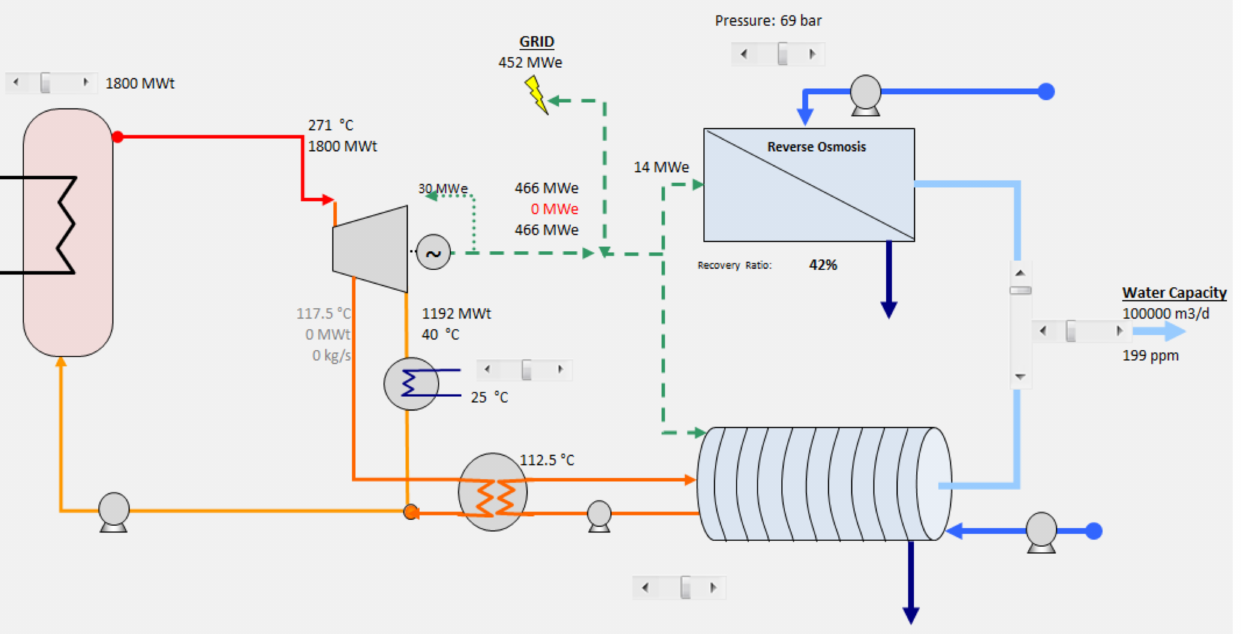
Figure 7. Sketch of coupled nuclear desalination system by using DEEP.